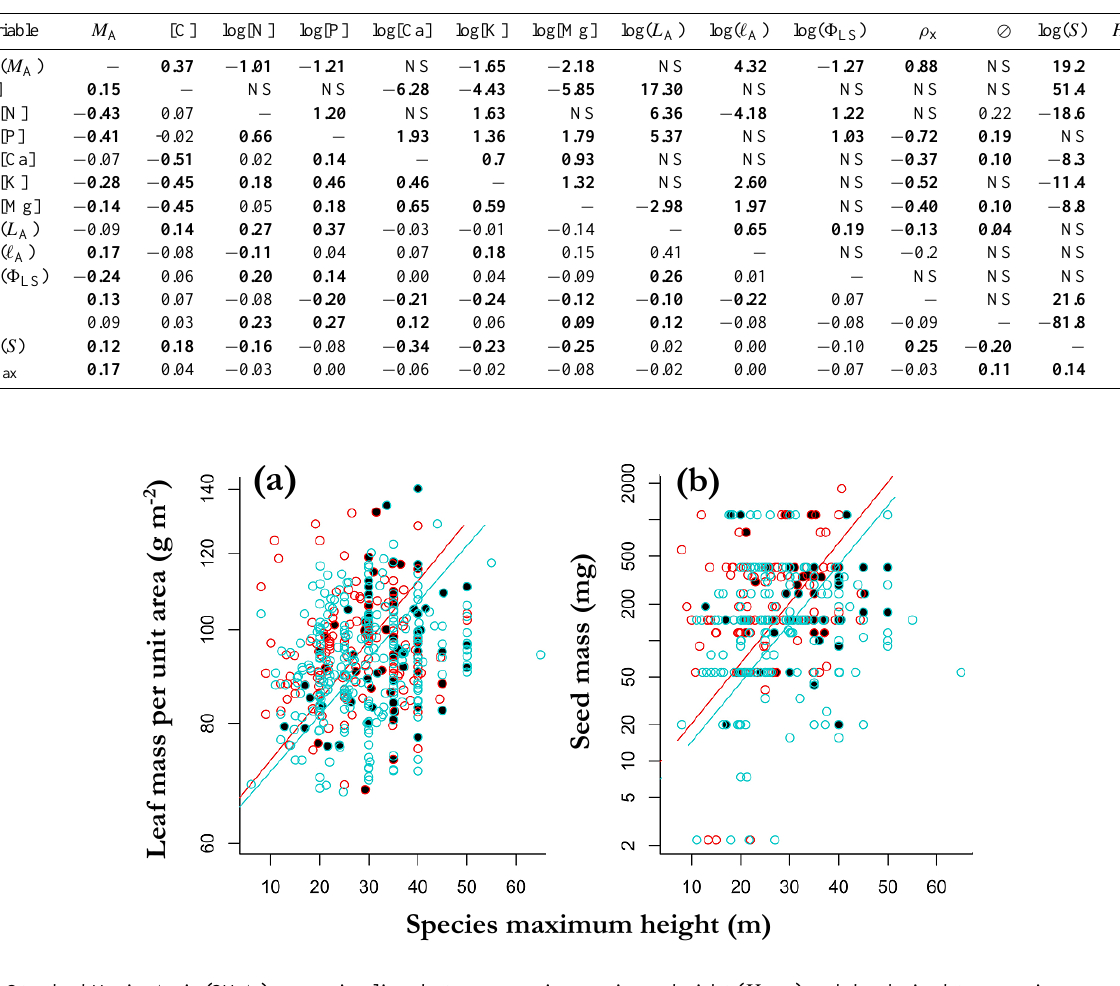
Fig. 3. Standard Major Axis (SMA) regression lines between species maximum height ( H max ) and the derived taxonomic components of leaf mass per unit area ( M A ) for the same species and the associated average seed mass ( S ) for the associated genus. Red open circles indicate species found on low fertility sites and the blue open circles indicate species found on high fertility sites. Species found on both soil fertility groups are indicated with closed circles (see text for details). Red solid lines show the SMA model fit for low fertility species which is significantly different to the blue solid lines for high fertility soil species.